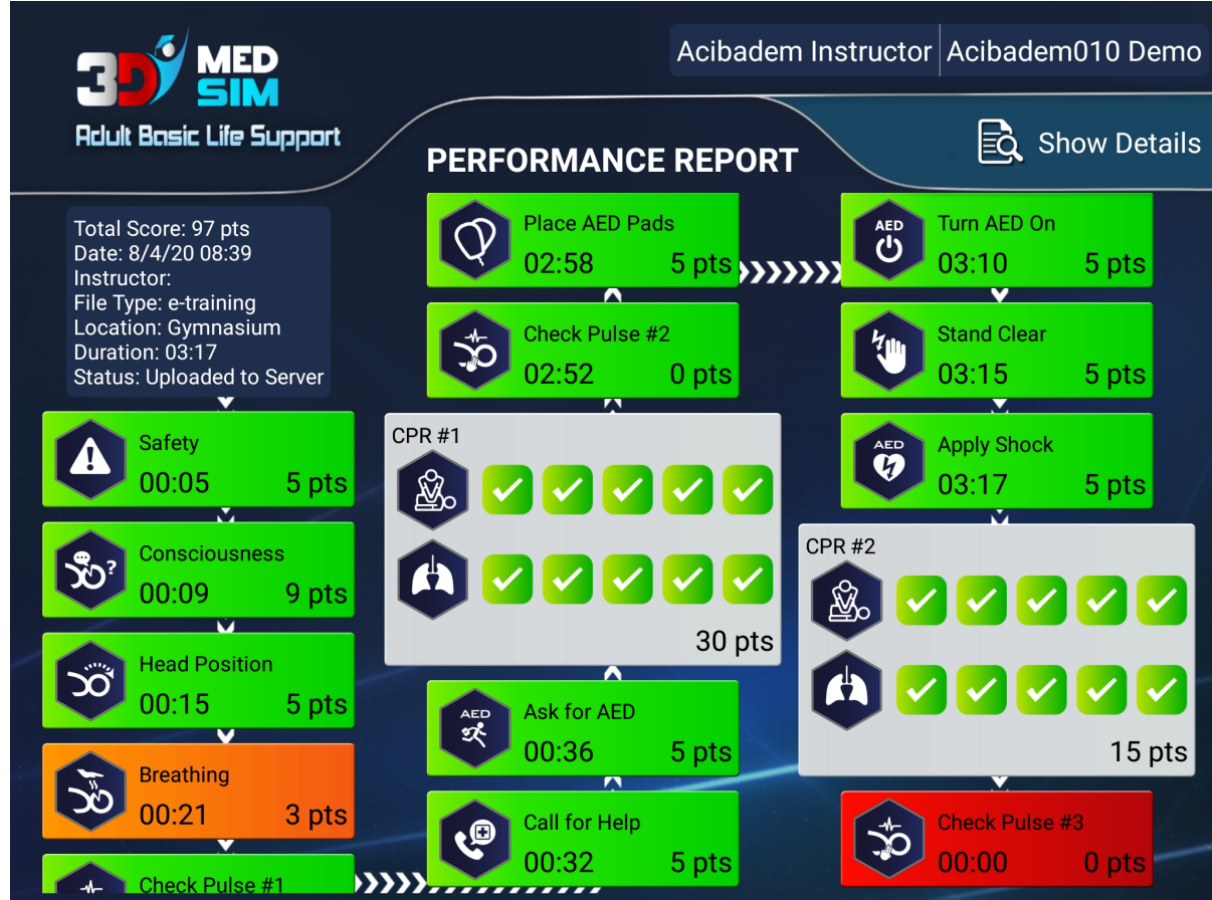
Figure 3. Performance report of BLS serious game